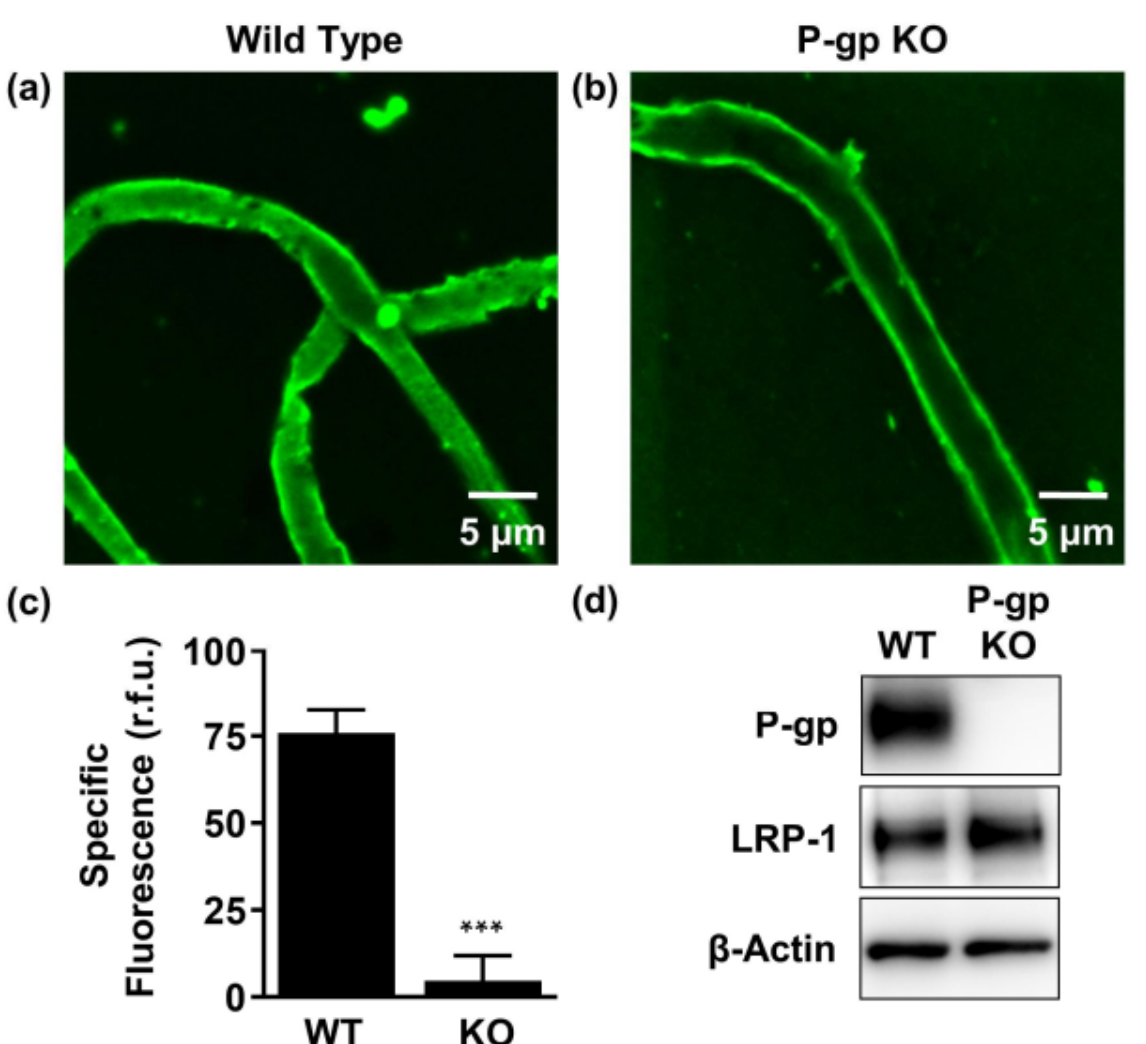
Figure 2. P-gp-mediated human A β 42 (hA β 42 ) transport in isolated brain capillaries. ( a ), ( b ) Representative confocal images showing accumulation of HiLyte TM -hA β 42 in capillary lumens isolated from wild-type (WT) mice, but not in capillaries from P-gp knockout (KO) mice after a 1-h incubation (steady state; 5 µ M HiLyte TM -hA β 42 ). ( c ) Data after digital image analysis using ImageJ. Specific fluorescence refers to the difference between total luminal HiLyte TM -hA β 42 fluorescence and HiLyte TM -hA β 42 fluorescence in the presence of the P-gp-specific inhibitor PSC833 (5 μ M). ( d ) Western blot showing P-gp protein expression in isolated capillaries from WT mice, but not in capillaries isolated from P-gp KO mice. In contrast, LRP-1 is expressed in isolated capillaries from both WT mice and P-gp KO mice. β -actin was used as the loading control. Statistics: data per group are given as mean ± SEM for 10 capillaries from one preparation (pooled tissue: WT ( n = 10 mice), P-gp KO ( n = 10 mice)). Shown are relative fluorescence units ((r.f.u.) scale 0–255). *** Significantly lower than control, p < 0.001.